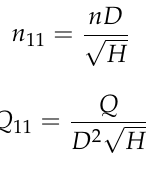
Figure 5. Test site.